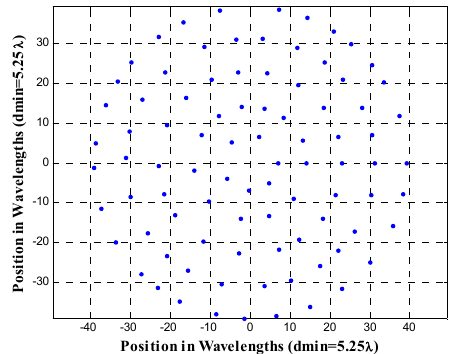
Figure 8. Antenna array configuration of the design case of UW-ACRA elements of N T = 90 antenna elements with N r = 5 rings at a frequency f = 10.5 f 0 , corresponding to a minimum element spacing of 5.25 λ .